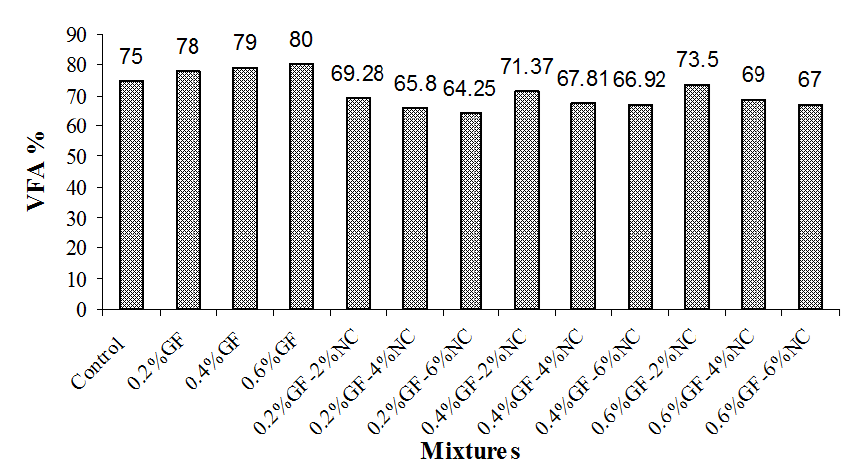
Fig. 7. Voids filled with asphalt of the